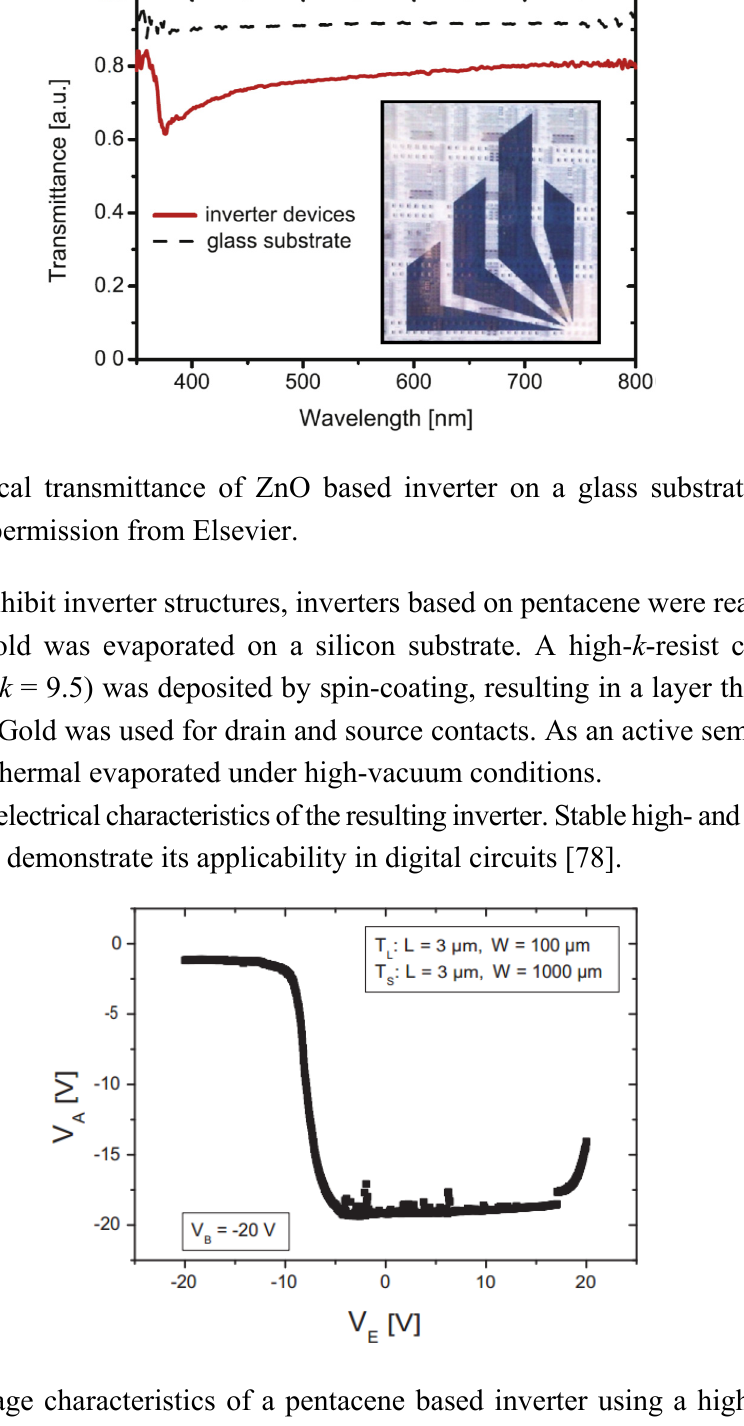
Figure 22. Voltage characteristics of a pentacene based inverter using a high- k dielectric (t ins = 300 nm) with the output voltage V A , input voltage V E and operating voltage V B . Adapted from